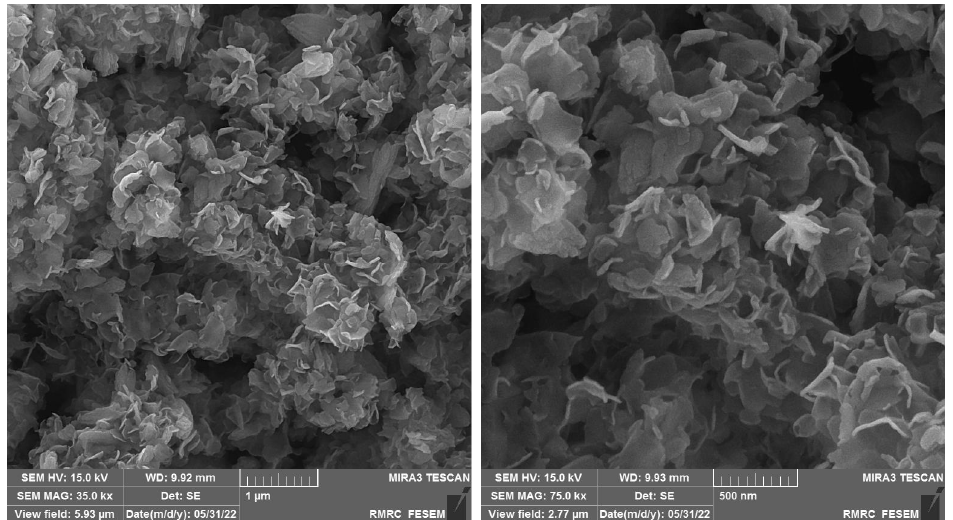
Figure 1. FE-SEM images prepared from as-constructed bimetallic NiCo-MOF nanosheets with different magnifications.